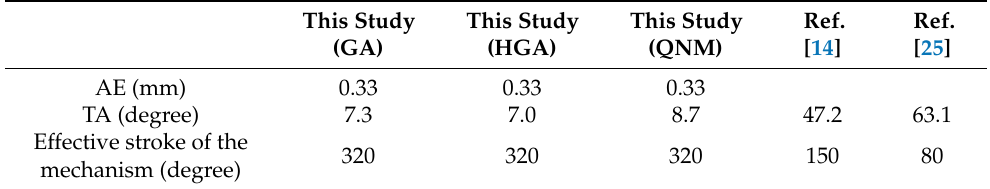
Table 5. Comparative results between proposed and classic methods in terms of design